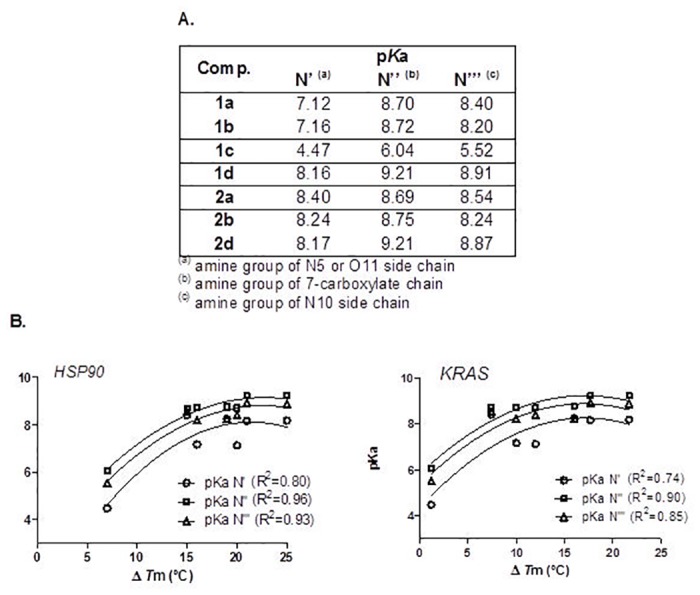
Basicity of side chains correlates positively with thermal G4 stabilization.
A. Calculated pKa values of side chain amine groups by SPARC (v. 4.6). B. Plots of variation of G4 thermal stabilization by compounds (ΔT
m) with basicity (pKa) of side chains groups.